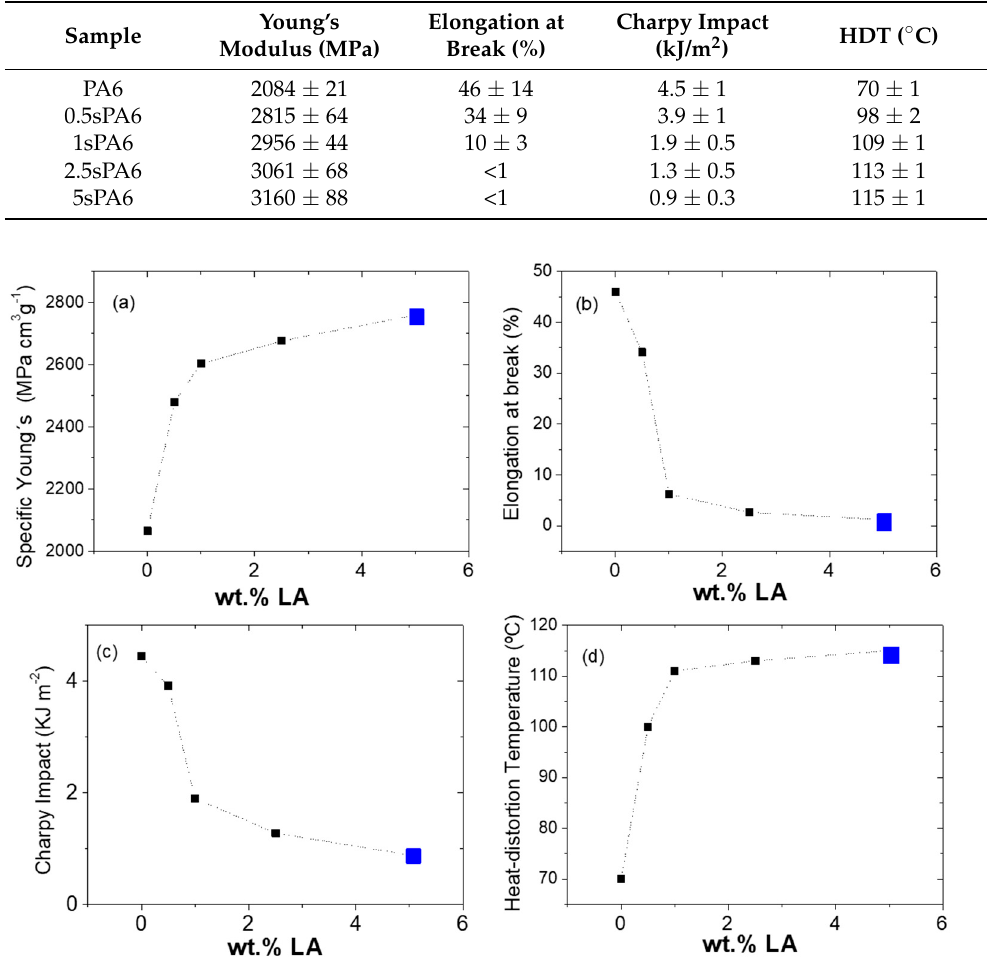
Figure 10. Specific mechanical properties of modified polyamides (sPA6) under different preparation approaches as a function of the 5-aminoisophthalic acid content: ( a ) Young’s modulus, ( b ) elongation at break, ( c ) Charpy impact test and ( d ) heat-distortion temperature.